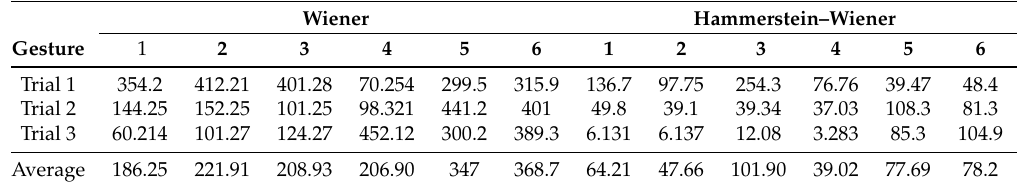
Total error, E T ( ◦ s), for each gesture and its average value when Wiener and Hammerstein–Wiener compensators are applied on the goniometric glove.